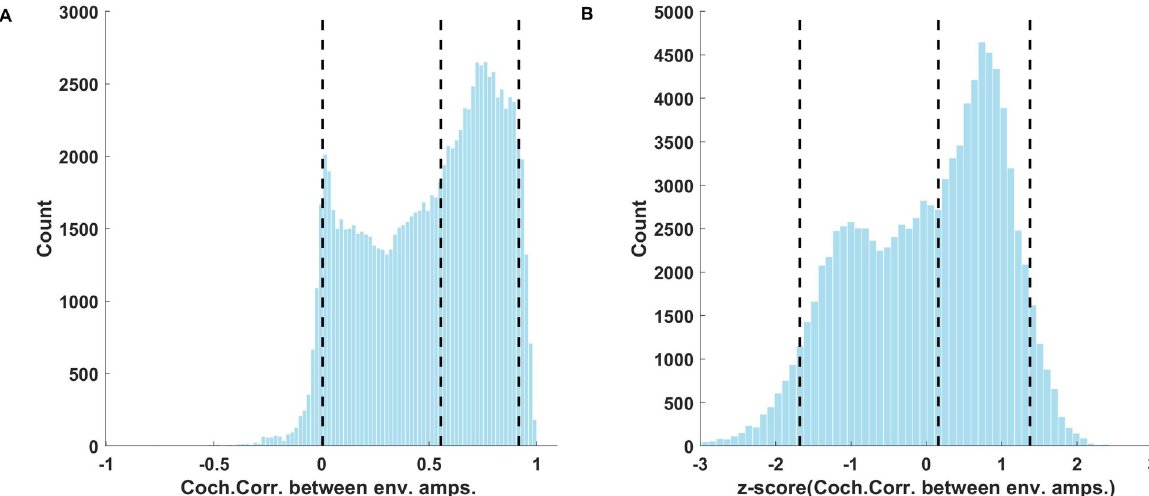
Fig 6. Distribution of cochlear correlation parameter values for the entire corpus. (A) Distribution of cochlear correlations between the envelope amplitudes of different cochlear frequency bands. The median, 5th and 95th centiles of the distribution (dotted lines) were 0.55, 0.0052 and 0.91 respectively. (B) Distribution of cochlear correlations after